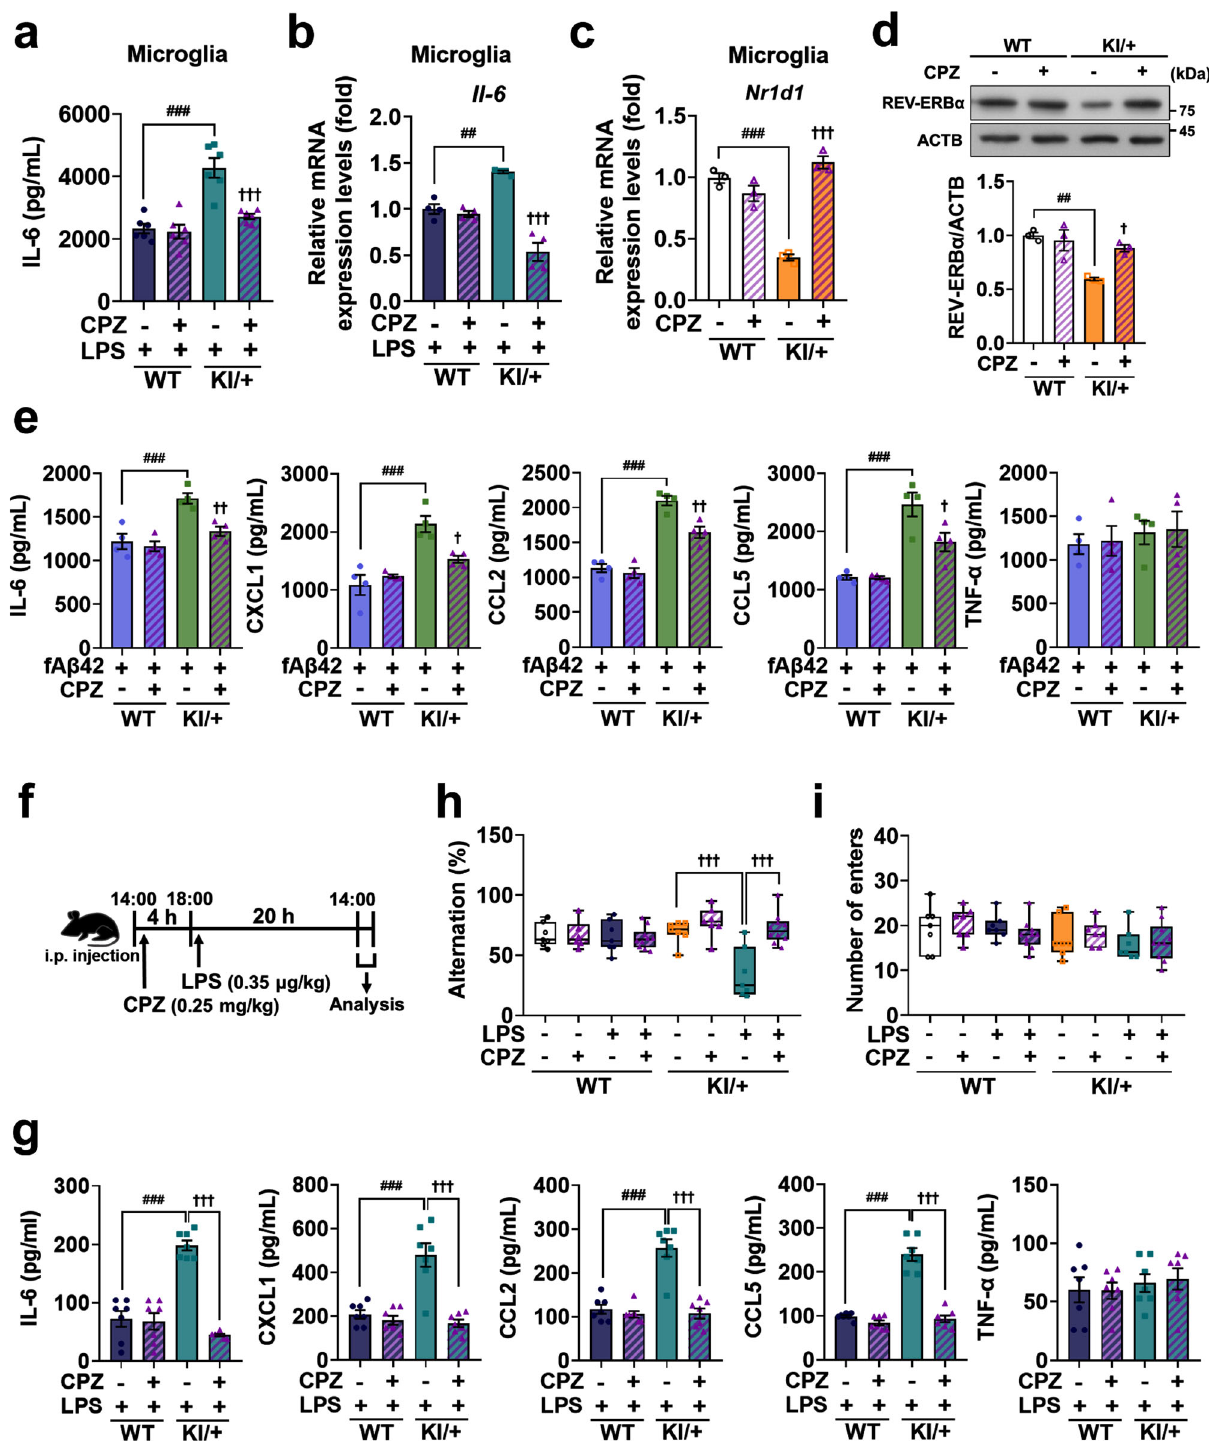
dose-dependent manner (Supplementary Fig. 10c, f). Therefore MAPK1/3 or GSK3 β was not closely associated with PI3K/AKT1 overactivation under our experimental condition. These data indicate that the overactivation of PI3K/AKT1 pathway is the proximal event involved in Nr1d1 suppression in KI/ + microglia. To sum up, CPZ restored REV-ERB α expression levels by correcting DNA hypermethylation through the inhibition of PI3K/AKT1 pathway in Psen2 N141I KI/ +